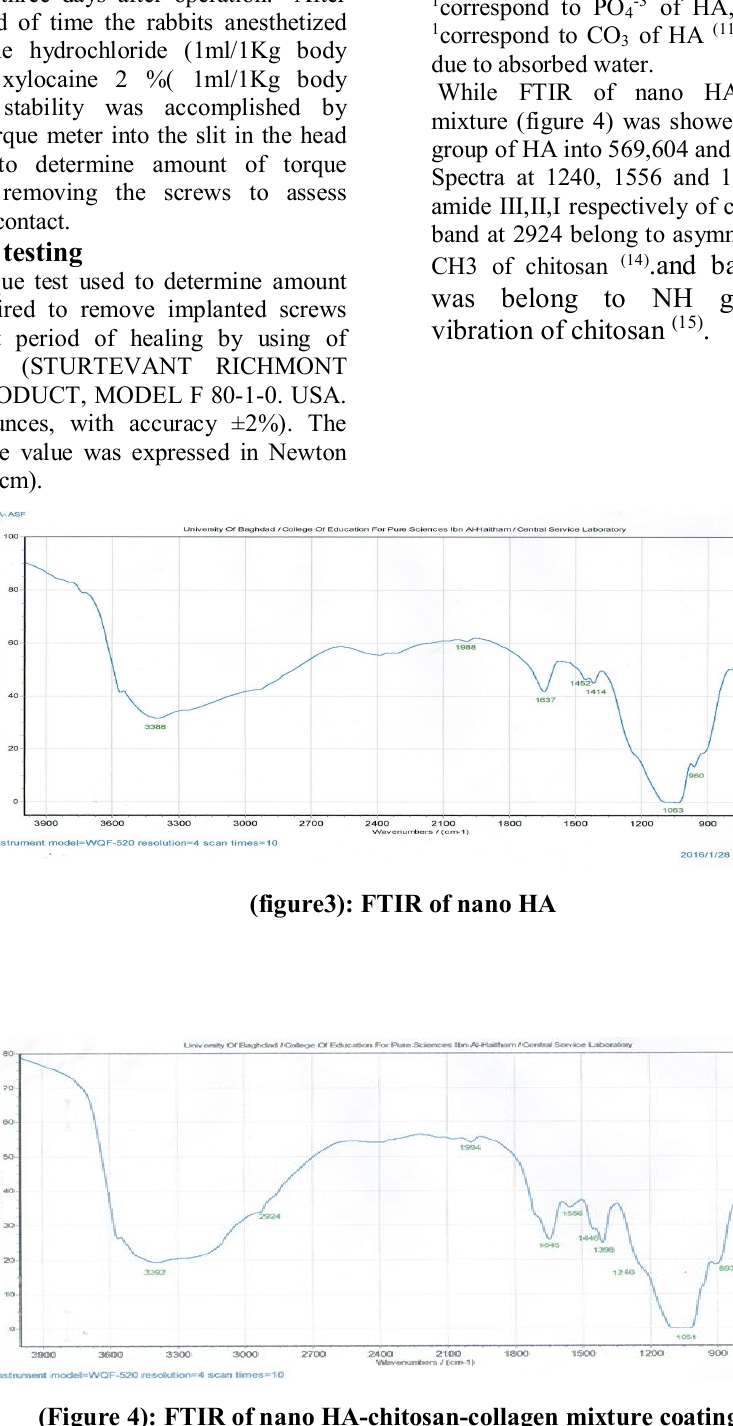
(Figure 4): FTIR of nano HA-chitosan-collagen mixture coating